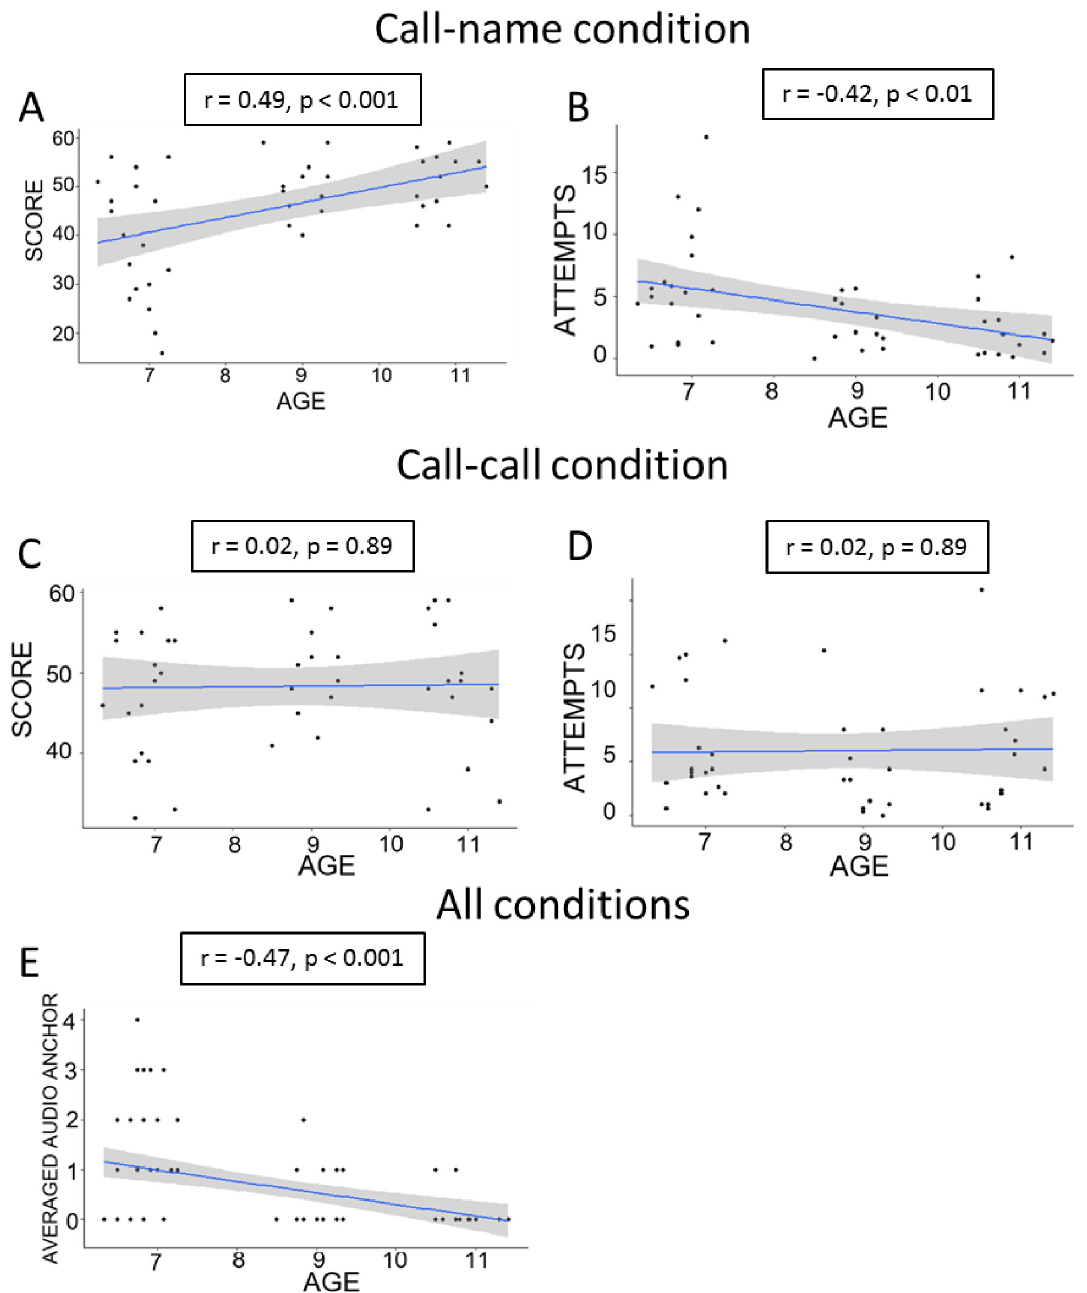
Fig 3. Linear regression analysis. Linear regression plot with 95% confidence intervals (shaded areas). The box on top of each plot shows the correlation and the significance level. Top row shows the linear regression in the call-name condition for the score (A) and the number of attempts (B). Middle row shows the linear regression in the call-call condition for the score (C) and the number of attempts (D). Bottom row shows the linear regression for both conditions for the Audio-anchor